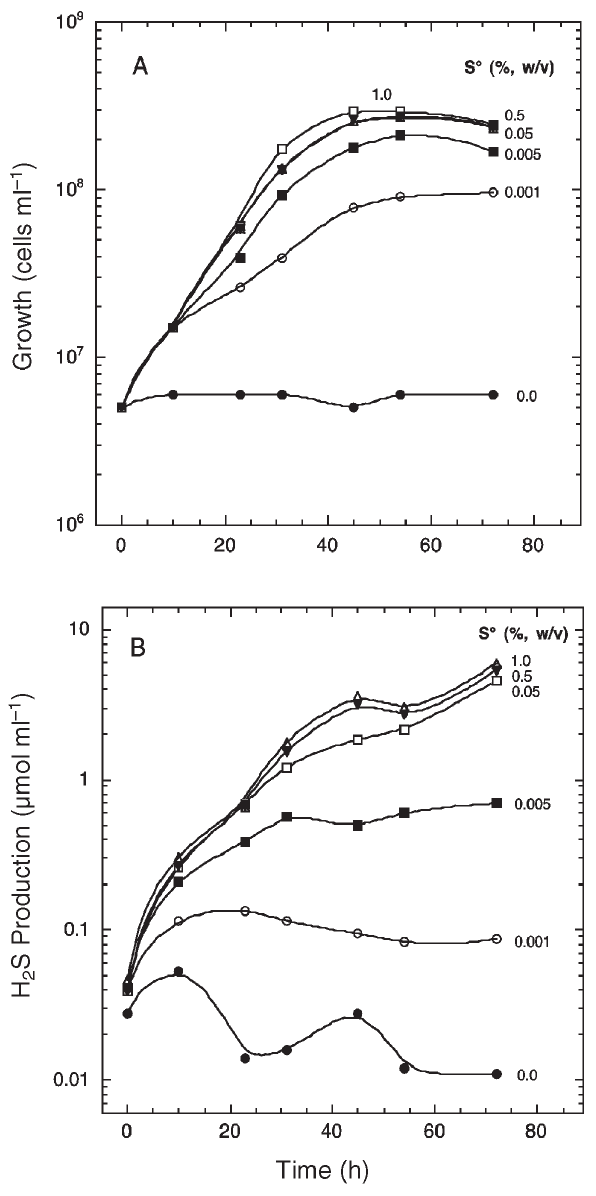
Figure 3. Growth and H 2 S production of S. marinus . (A) Growth of S. marinus in the presence of different concentrations of sublimed S ° . Cell density was obtained by direct cell counting. (B) Production of H 2 S in the presence of different concentrations of sublimed S ° . Cells were grown in 25 ml of modified 0.8× SME medium at 85 °C.